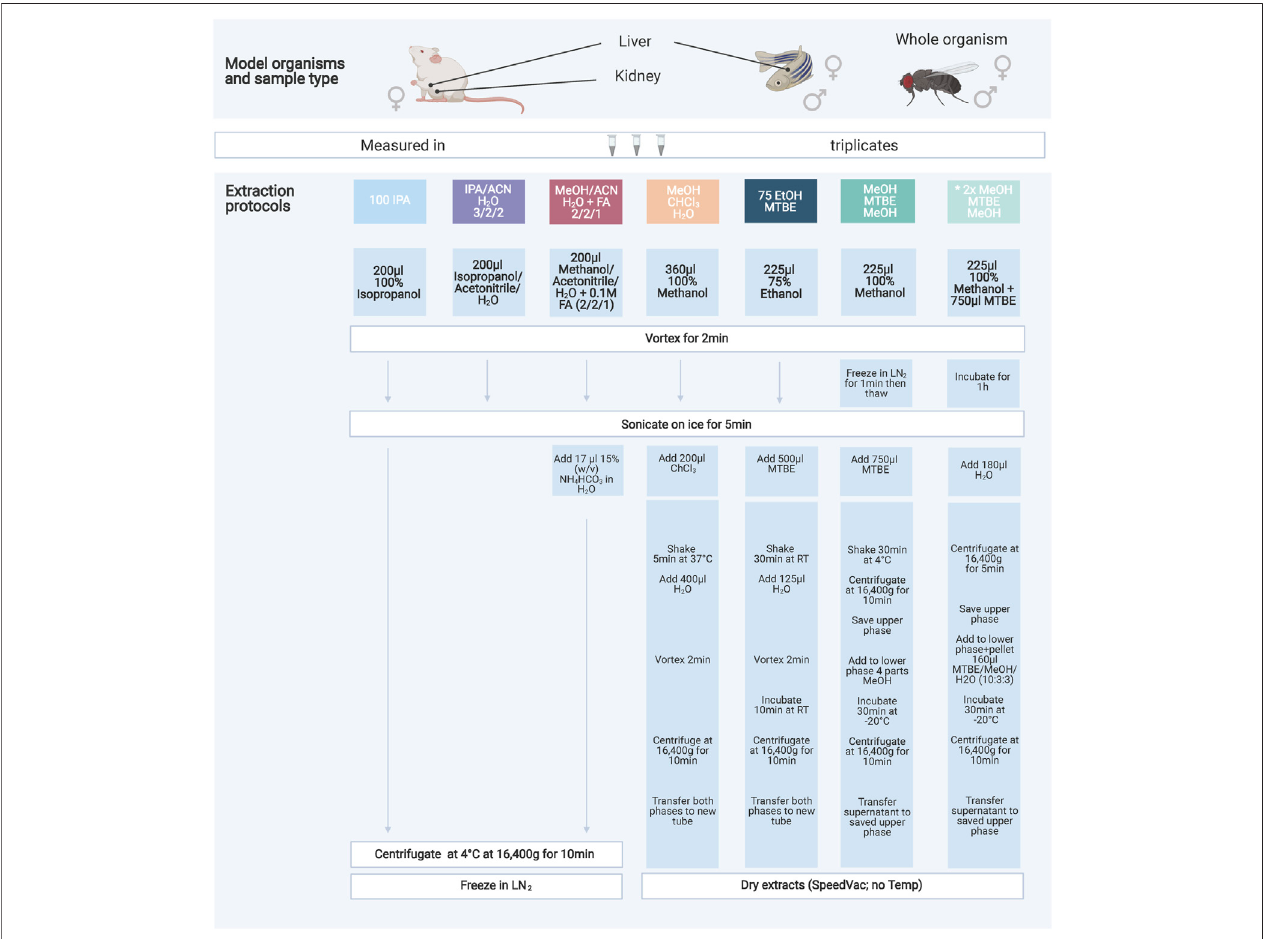
FIGURE 1 | Overview of the seven extraction protocols used as well as the model organisms and sample types investigated. The protocols increase in handling effortandcomplexityfromlefttoright.Thecolorcodeindicatessimilaritiesamongsttheprotocolseitherthroughsolventsorchemicalsused.Allextractionproductswere stored at − 80 ° C until further processing. A list of abbreviations can be found